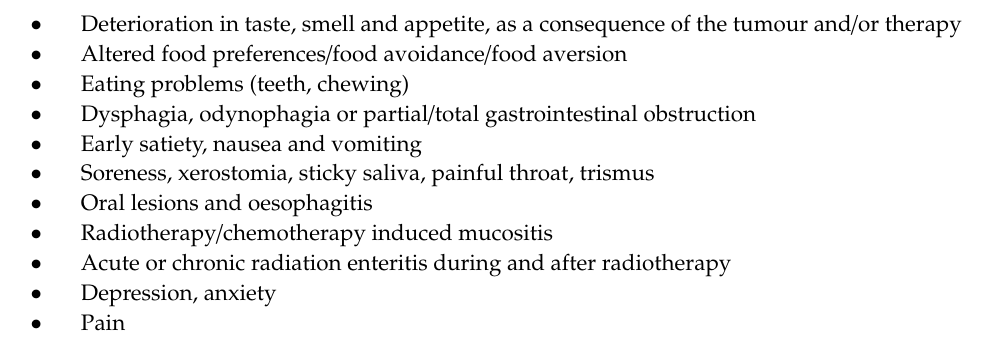
Table 1. Common causes for a poor nutrient intake in cancer